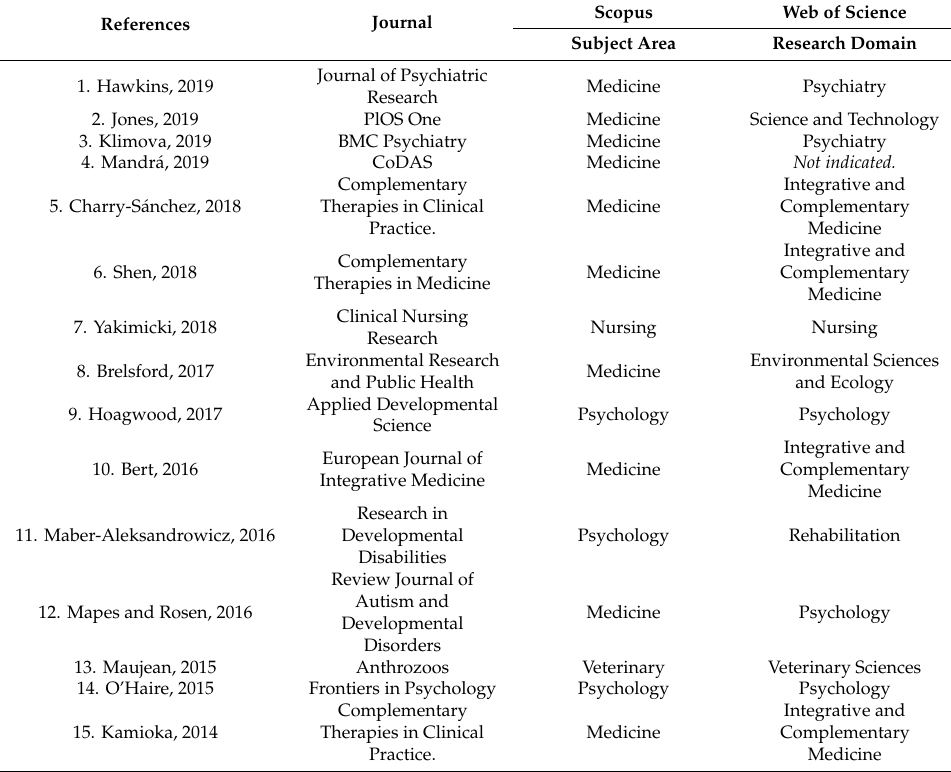
Table 1. Indicated disciplinary areas in systematic reviews (SRs)